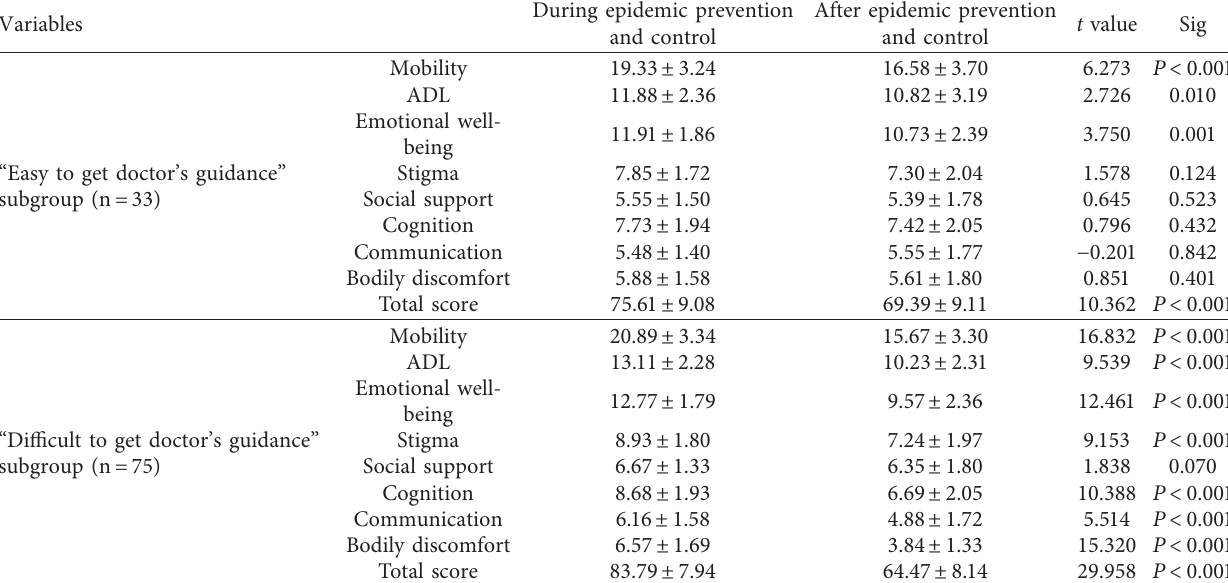
Table 3: Comparison of PDQ-39 outcomes between during and after epidemic prevention and control in patients who could easily receive doctor’s guidance and those who found it difficult.